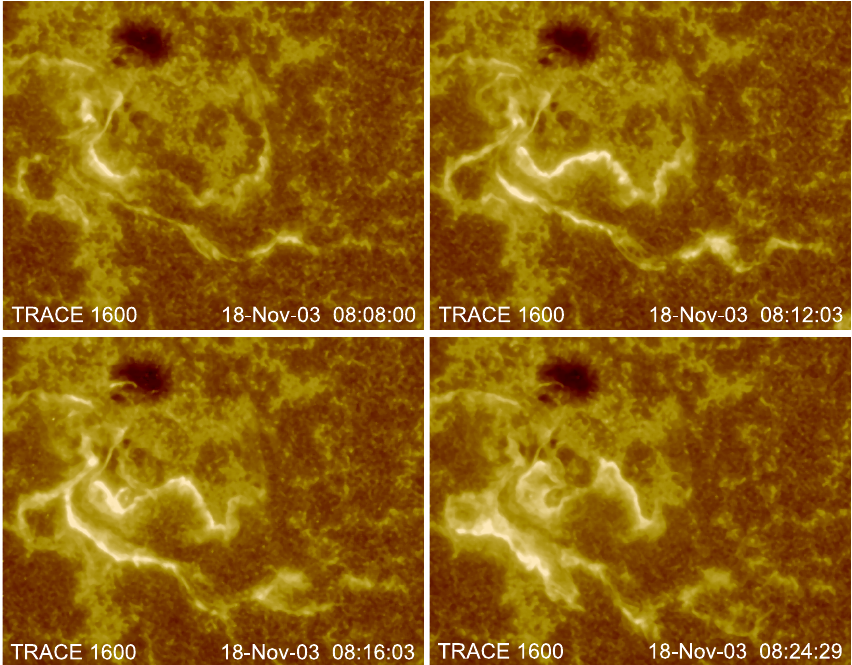
Fig. 2. Temporal evolution of the flare ribbons during the impulsive phase in TRACE UV. Solar north is up, west is to the right. FOV: 320 00 × 250 00